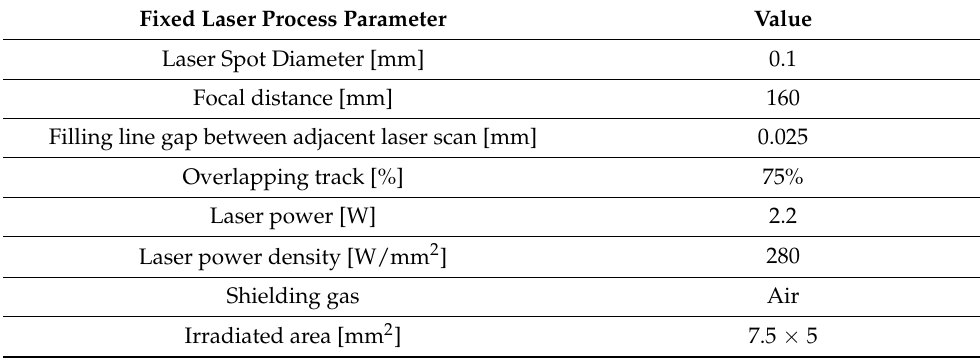
Table 1. Fixed laser parameters.